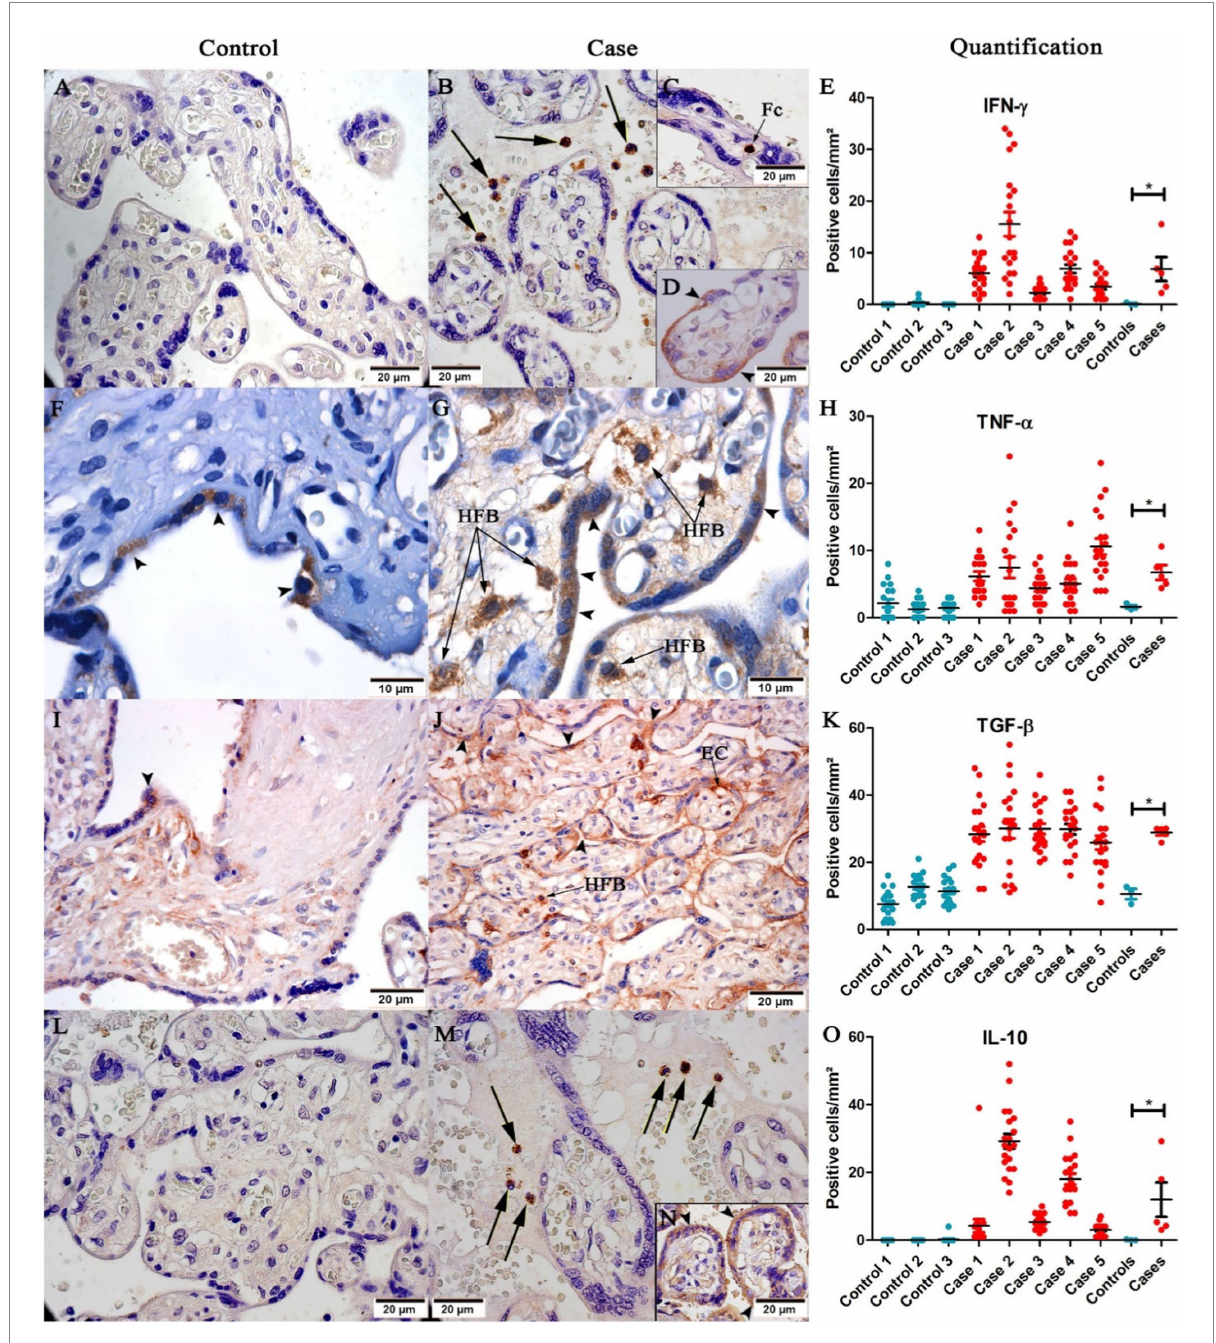
FIGURE 4 Representative images of cytokine detection in placental tissue. (A) No IFN- γ expression in control placenta; (B) IFN- γ expression in inflammatory cells (black arrows), (C) fetal cells (Fc), (D) and trophoblast cells ( control placenta; (G) TNF- α expression in Hofbauer cells (HFB) in placental case; (I) Low expression of TGF- β in trophoblast cells ( placenta; (J) TGF- β expression in trophoblast cells ( (M) IL-10 expression in inflammatory cells (black arrows), and (N) trophoblast cells ( (O) IL-10 expression. (* p < 0.05). Data are represented as mean ± SDM. Magnification: 40× (A,B,C,D,I,J,L,M,N) , 100× (F,G)